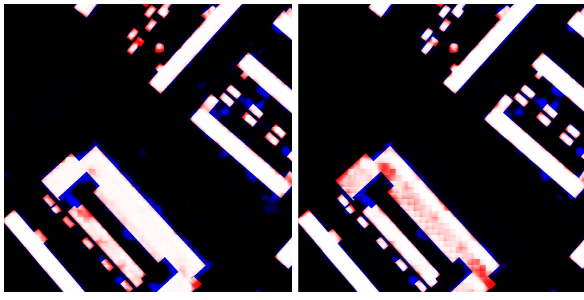
Figure 4. Results from AlexNet (left) and DenseNet (right). White and black colors indicate true positives and true negatives. Red and blue colors indicate false negatives and false